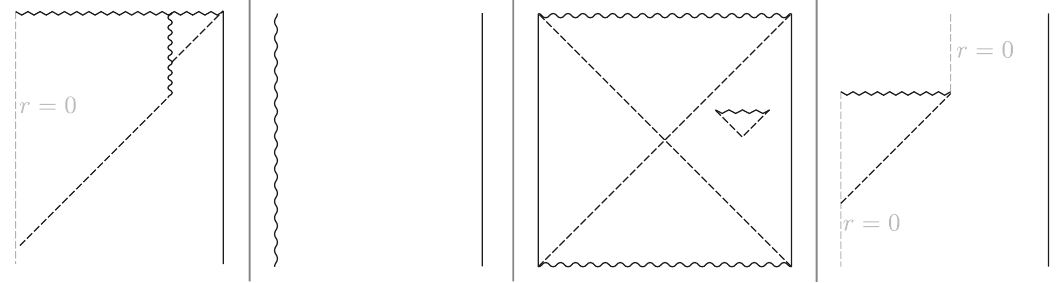
Figure 6 . Sketched conformal diagrams of four spacetimes. The two left-most spacetimes are nei- ther globally hyperbolic nor strongly asymptotically predictable, but they are devoid of evaporating singularities. The two right-most spacetimes contain evaporating